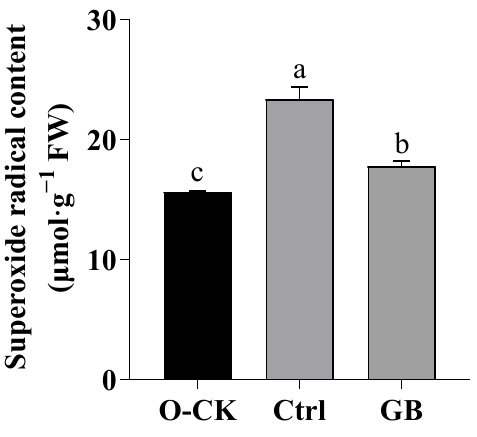
Figure 2. E ff ects of GB on O 2· − in B. rapa under heat stress. Data are shown as mean ± SD. Di ff erent lowercase le tt ers indicate signi fi cant di ff erence at p < 0.05. O − CK, optimum conditions, foliar sprayed with water; Ctrl, foliar sprayed with water before exposure to heat stress; GB, foliar sprayed with GB before exposure to heat stress.